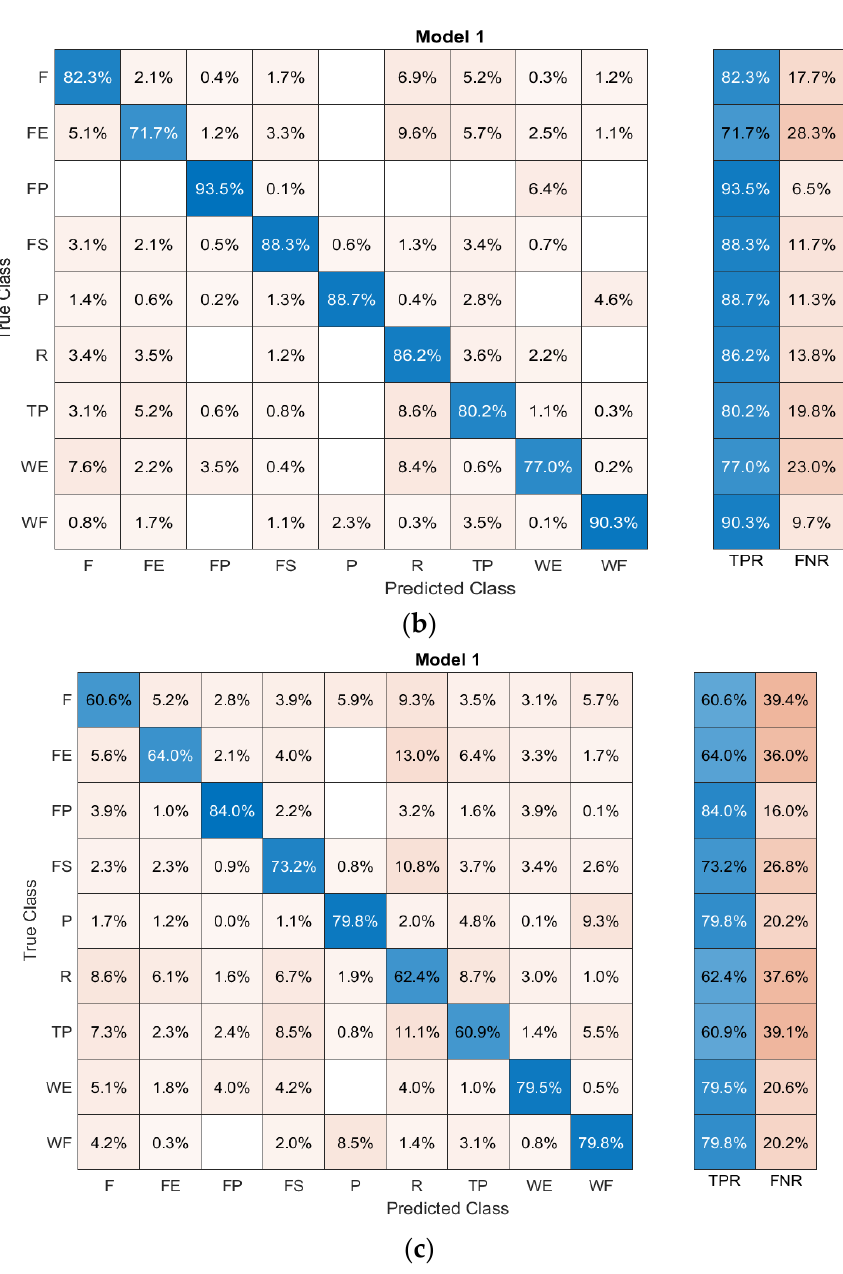
Figure 8. Confusion matrices of ( a ) elbow, ( b ) shoulder, and ( c ) ES movements; F: finger point, FE: finger extension, FP: forearm pronation, FS: forearm supination, P: power gesture, R: relax, TP: tripod, WE: wrist extension, and WF: wrist flexion.